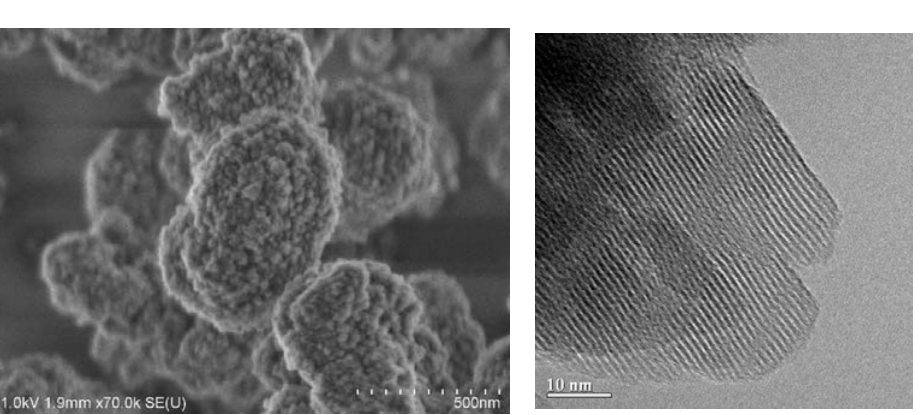
Figure 3. SEM/TEM of mesoporous Beta-3 zeolite